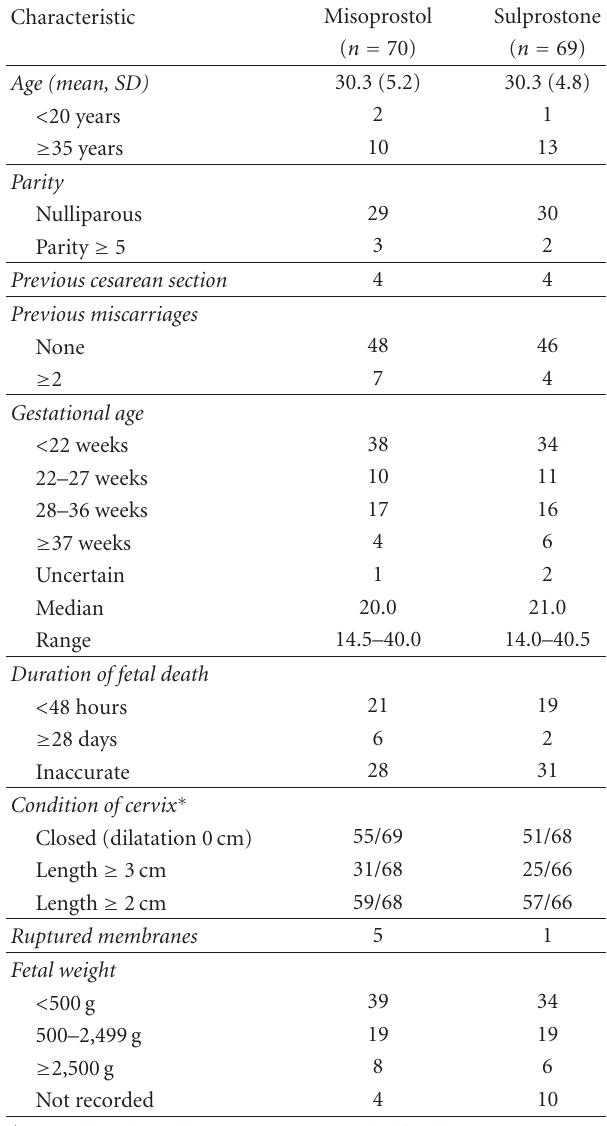
Table 1: Baseline characteristics (number) of the women included in the